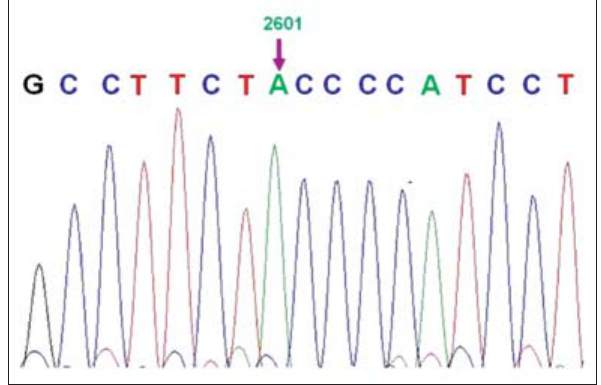
Figure-1: Chromatogram showing nucleotide change at position 2601 (G>A).